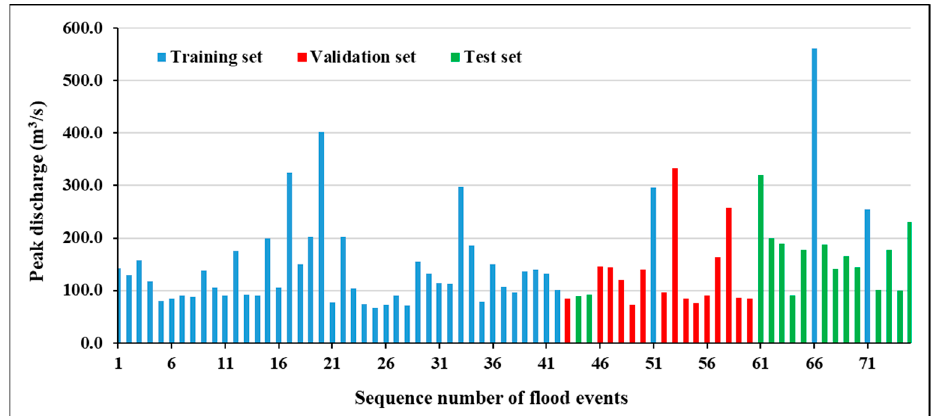
Figure 4. Partition of the sample set.